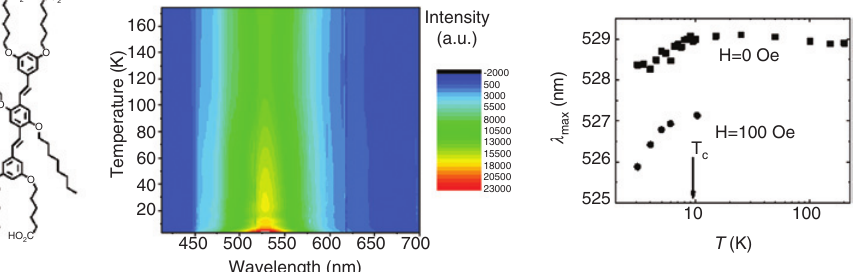
(OH) (OPV) ·2.6H O and temperature dependence 2 0.4 0.9 2 . C